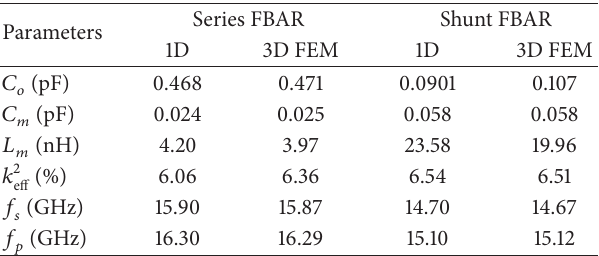
Table 6: Comparisons of 1D and 3D FEM of Filter B.